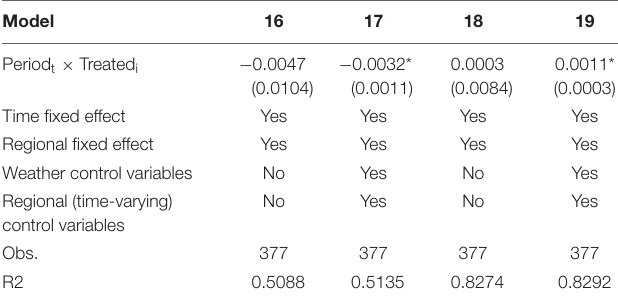
TABLE 6 | Analysis of policy effects from the perspective of milk processing enterprises and